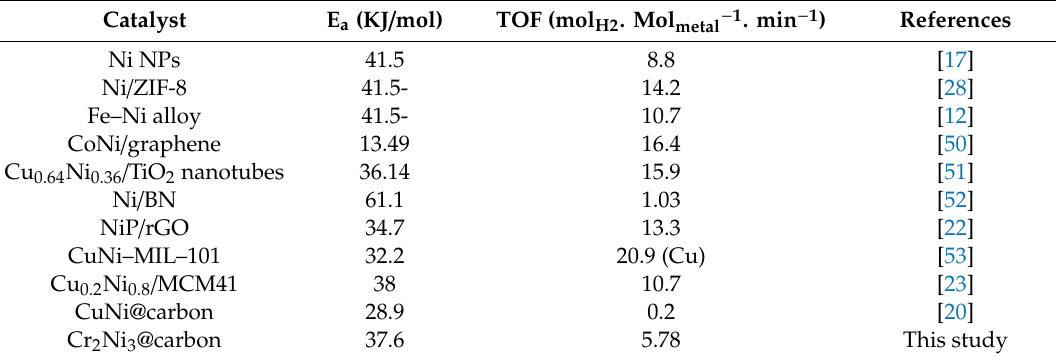
Figure 8. Evolution of H 2 gas by the hydrolytic dehydrogenation of ammonia borane (AB) in the presence of Cr 2 Ni 3 NPs@CNFs (15 wt% CrAc) at di ff erent temperatures ( a ), the plot of ln K vs. (1 / T) ( b ) and the plot of ln K D vs. (1 / T) ( c ). Table 1. Comparison of activation energies and TOFs of di ff erent Ni-based catalysts for the hydrolytic dehydrogenation of